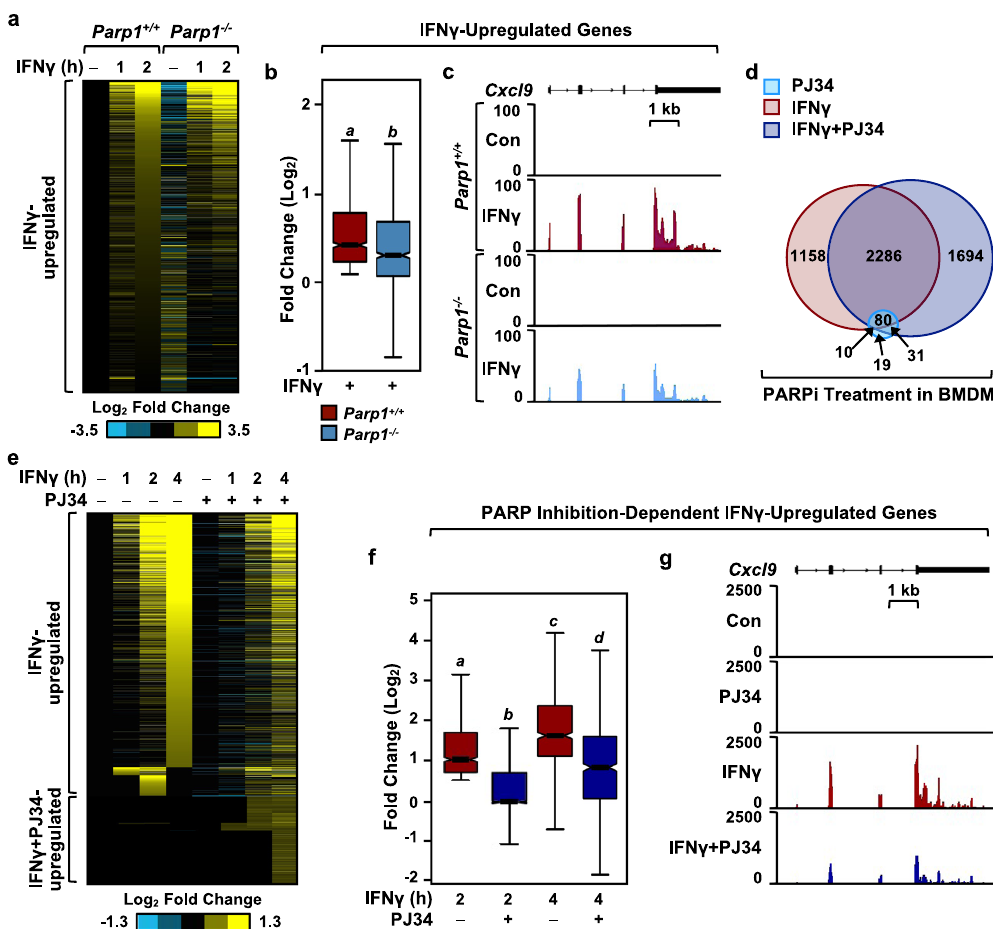
Fig. 1 PARP-1 regulates IFN γ -dependent gene expression in bone marrow-derived macrophages (BMDMs). a Heatmap of RNA-seq data representing changes in the expression of IFN γ -regulated genes from mRNA-seq in BMDMs from wild-type ( Parp1 + / + ) or Parp1 knockout ( Parp1 -/- ) mice. The cells were treated with IFN γ for the indicated times. b , c Box plots ( b ) and browser tracks ( c ) illustrating IFN γ -stimulated gene expression in Parp1 + / + or Parp1 -/- mice. BMDM cells were treated with IFN γ for 2 h and steady-state mRNA levels from RNA-seq were expressed as fold change relative to the untreated control. Boxes represent 25 th – 75 th percentile (line at median) with whiskers at 1.5*IQR. Boxes marked with different letters are signi fi cantly different from each other (Wilcoxon Signed-Rank test; p < 2.2 × 10 − 16 ). Box plots represent 960 genes. d Venn diagrams showing differentially regulated genes from RNA-seq in BMDMs upon treatment with PJ34 (light blue), IFN γ (red), or IFN γ + PJ34 (blue). Numbers indicate the number of differentially regulated genes compared to the untreated control. e Heatmap of RNA-seq data representing the changes in gene expression of IFN γ - regulated genes upon co-treatment with PJ34. f , g PARP-1 catalytic activity is required for IFN γ -dependent gene expression in BMDMs. Box plots ( f ) and browser tracks ( g ) representing changes in gene expression from RNA-seq upon IFN γ treatment ± PJ34 ( n = 1053 genes; Wilcoxon Signed-Rank test; p < 2.2 × 10 − 16 ). Boxes represent 25 th – 75 th percentile (line at median) with whiskers at